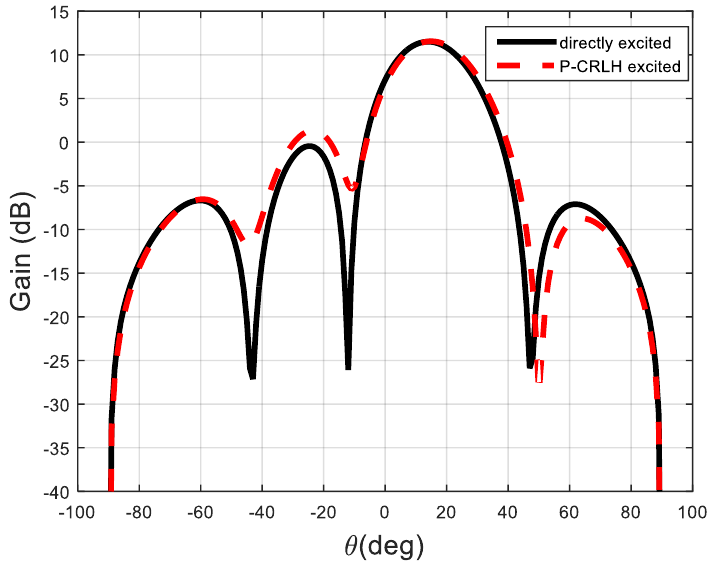
Figure 11. Simulated main beam at off-broadside 𝜃 0 = 15 ° with directly excited and P-CRLH-excited phases.